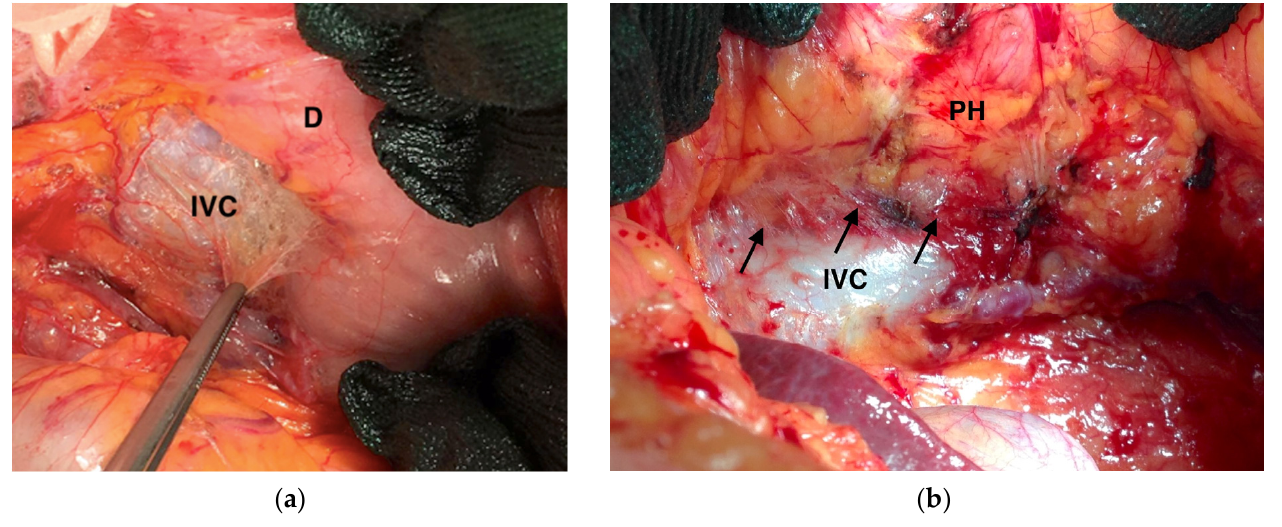
Figure 6. Intraoperative frames highlighting fibrosis induced by neoadjuvant chemotherapy (black arrows): ( a ) Kocher’s maneuver; ( b ) Kocher’s maneuver showing adhesion between inferior cava vein, ovarian vein, and pancreatic head. IVC: Inferior Vena Cava; D: Duodenum; PH: Pancreatic Head.